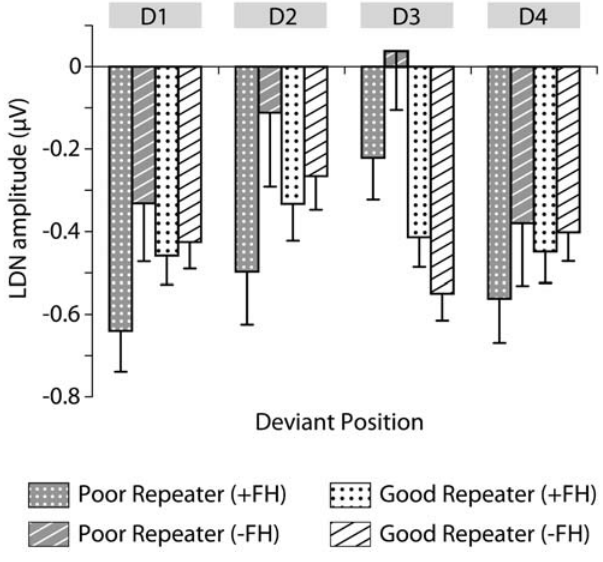
Figure 3. LDN amplitudes as a function of family history and nonword repetition status. Mean amplitude of LDN in relation to position of deviant syllable; nonword repetition status (Poor or Good); and, family history ( + FH or 2 FH). Error bars show standard